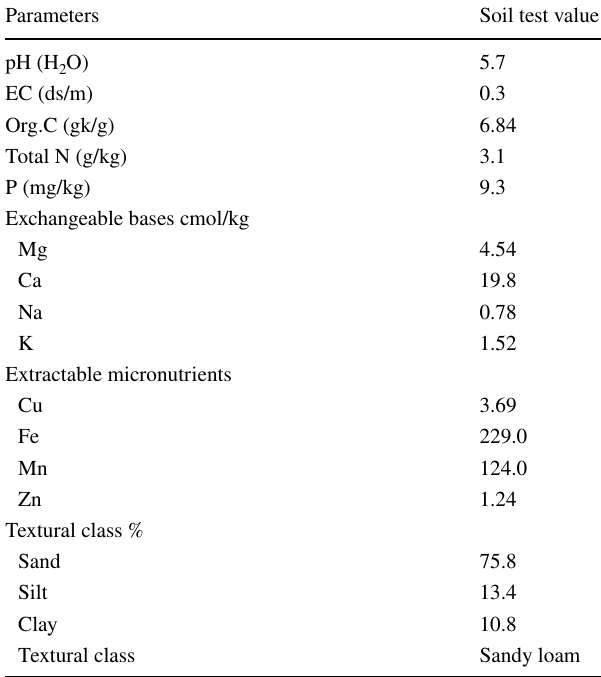
Table 2 Physico-chemical properties of experimental soil